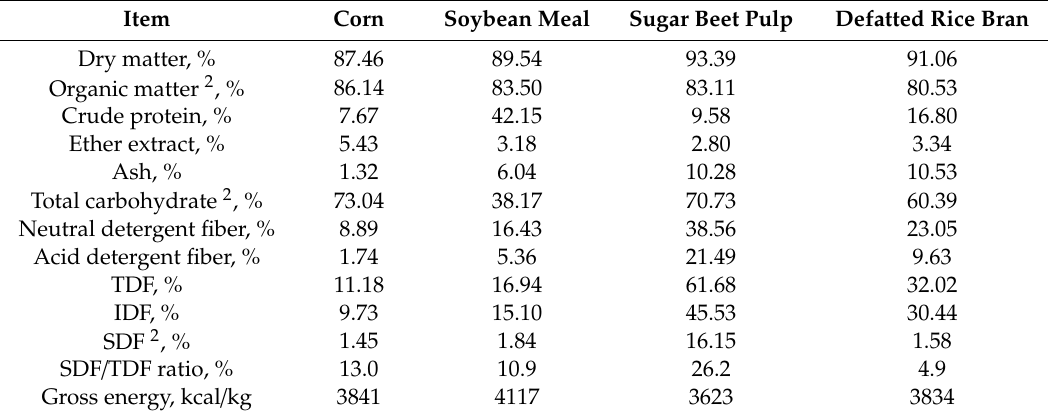
Table 1. Analyzed chemical composition of ingredients (as-fed basis) 1